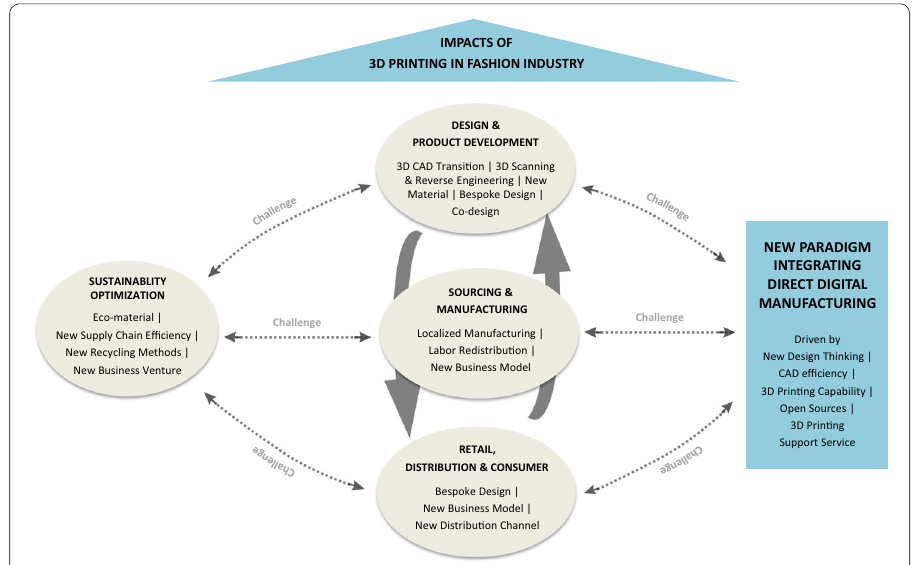
Fig. 1 The conceptual model of 3D printing impact in the fashion